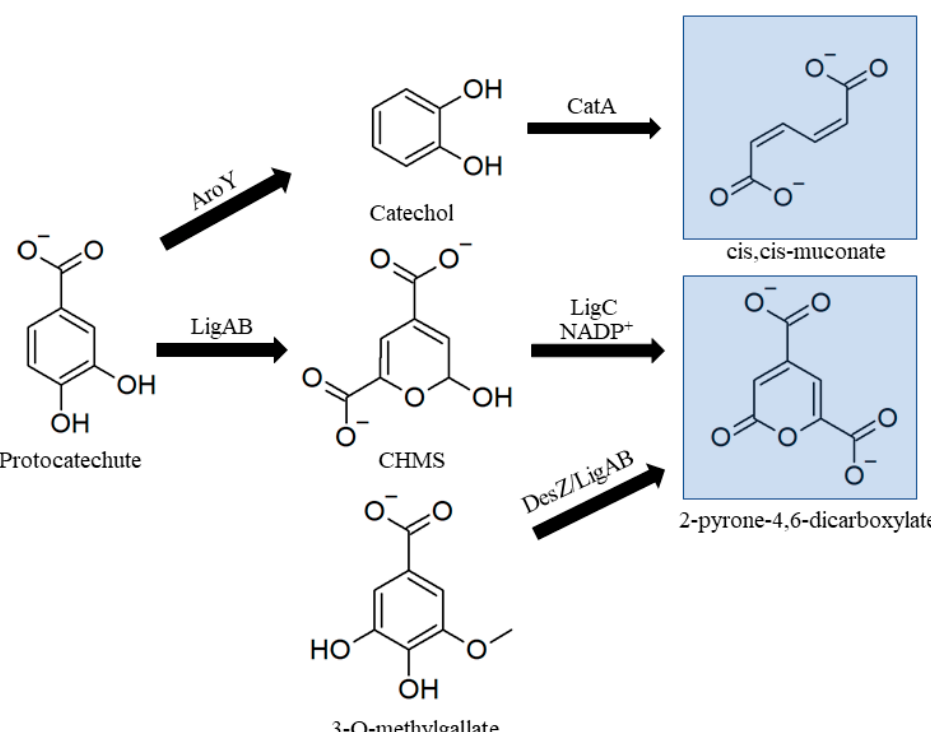
Figure 8. Lower pathways to produce value-added chemicals from lignin and the genes involved.